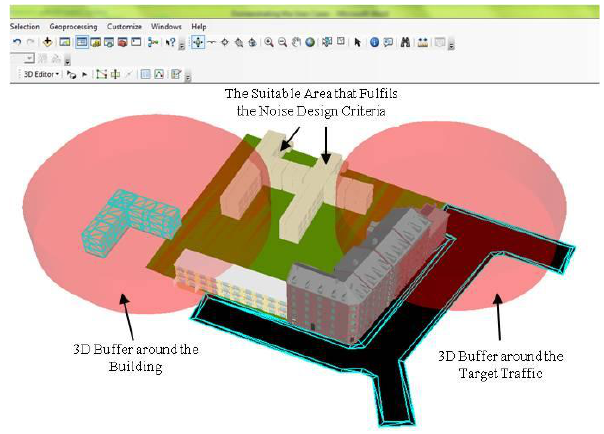
Figure 16. 3D Buffer Intersect with the Tested